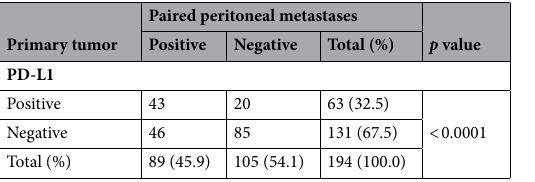
Table 2. Comparison of PD-L1 status between primary EOC and corresponding peritoneal metastases.